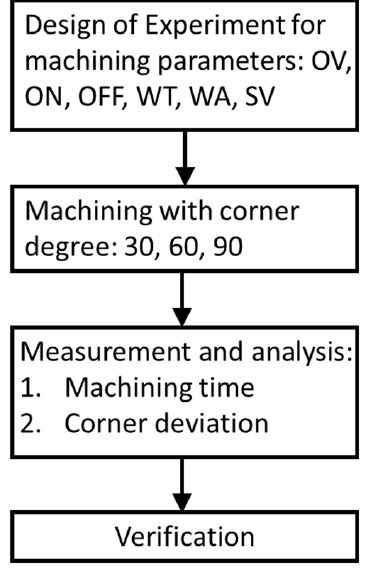
Figure 2. Flowchart of experiment.